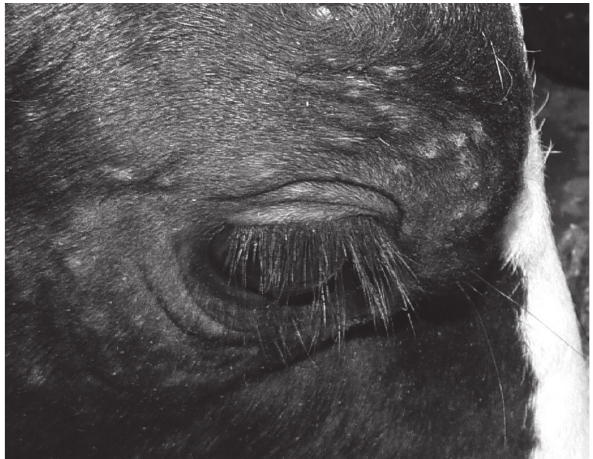
Fig. 2. – Many cutaneous nodes surround the eyes of the demodi- cidosis affected